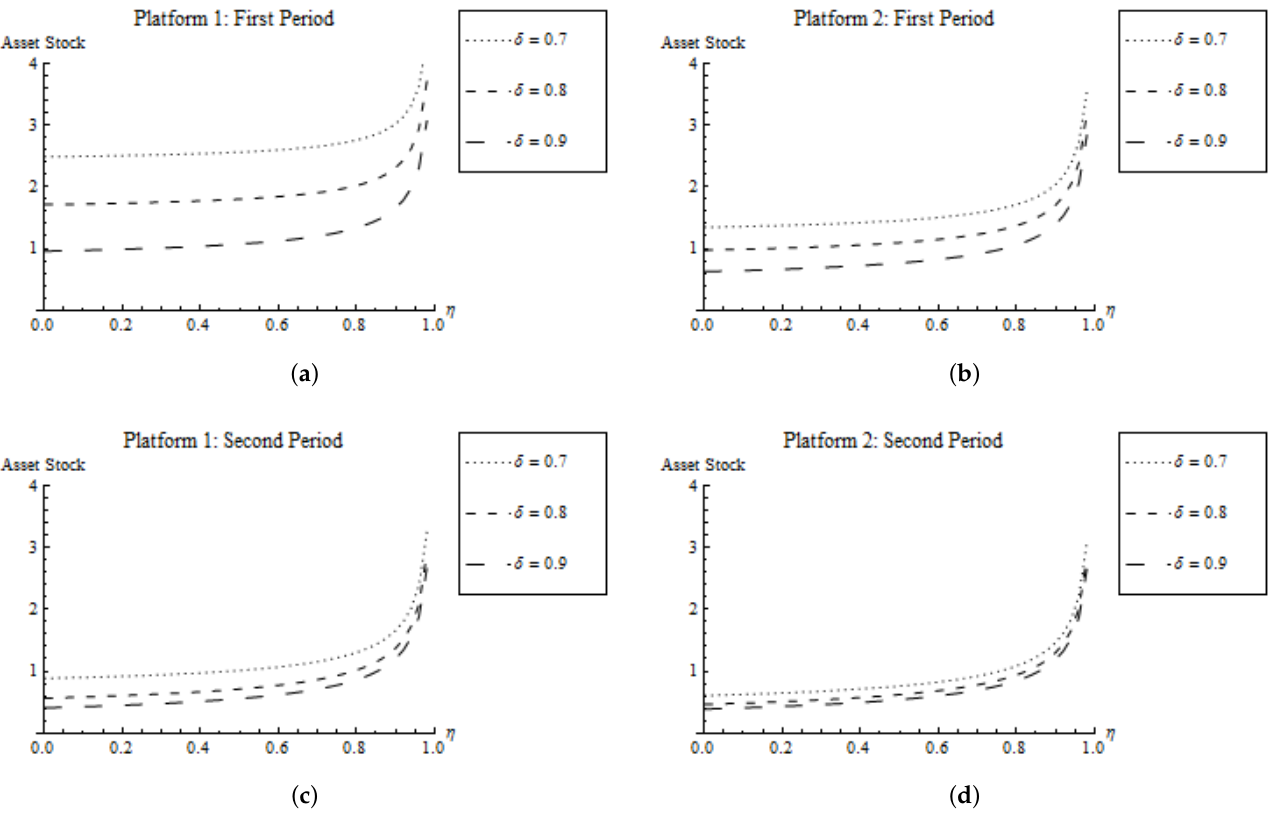
Figure 2. Asset stocks for quadratic costs. ( a ) Platform 1: First period, ( b ) Platform 2: First period, ( c ) Platform 1: Second period, ( d ) Platform 2: Second